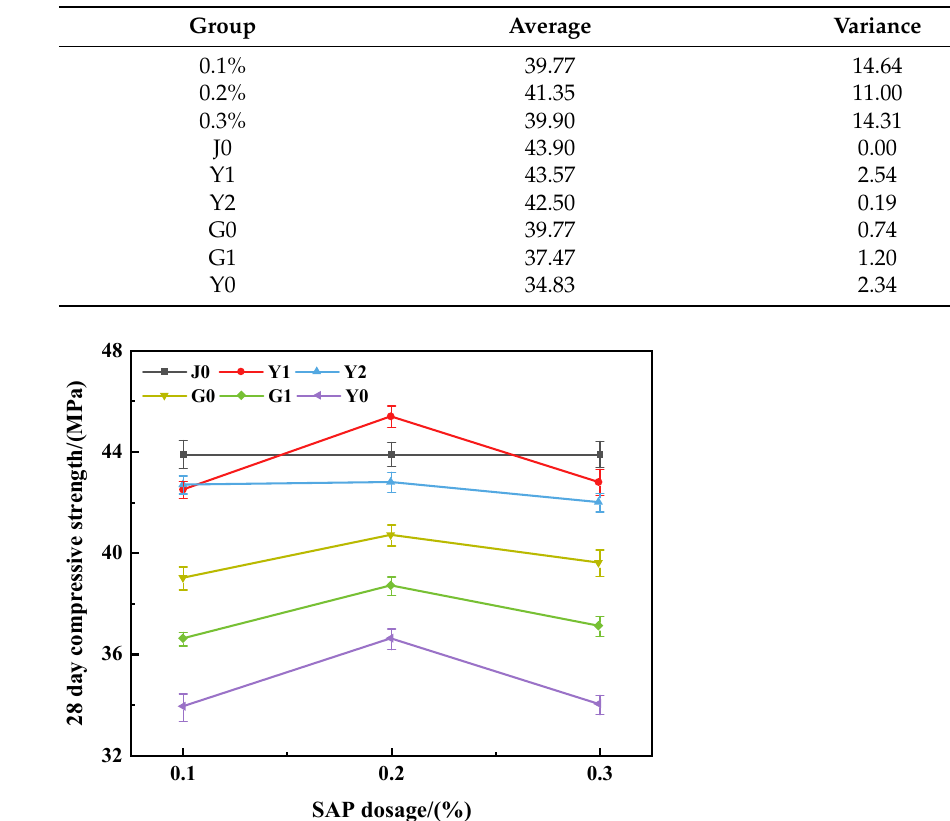
Table 3. Mean and variance analysis of compressive strength.